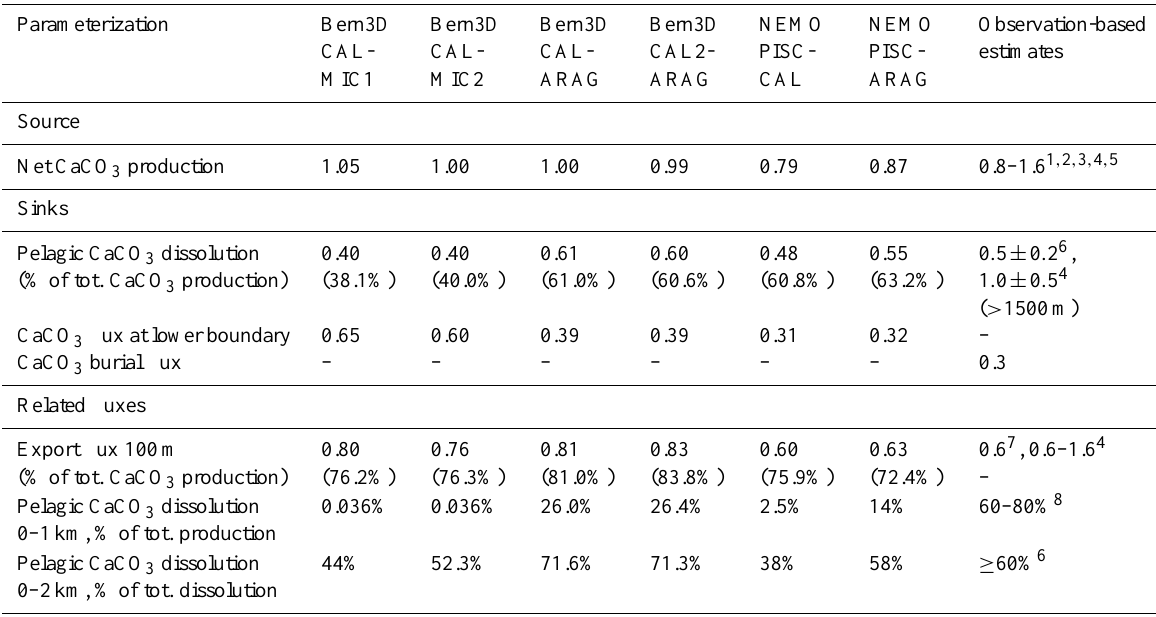
Table 2. The pre-industrial CaCO 3 budget: results are for different parameterizations of the CaCO 3 production in the Bern3D/PISCES model and the NEMO/PISCES model, labeled PISC-CAL (Gehlen et al., 2007), and PISC-ARAG (Gangstø et al., 2008). Parameterizations for the carbonate cycle are comparable between versions CAL-MIC2 and PISC-CAL and between versions CAL-ARAG and PISC-ARAG. The lower boundary represents the deepest model grid boxes. The flux at the lower boundary is not to be compared with estimates of the burial flux; the latter is not modeled in this study. Units are PgCyr − 1